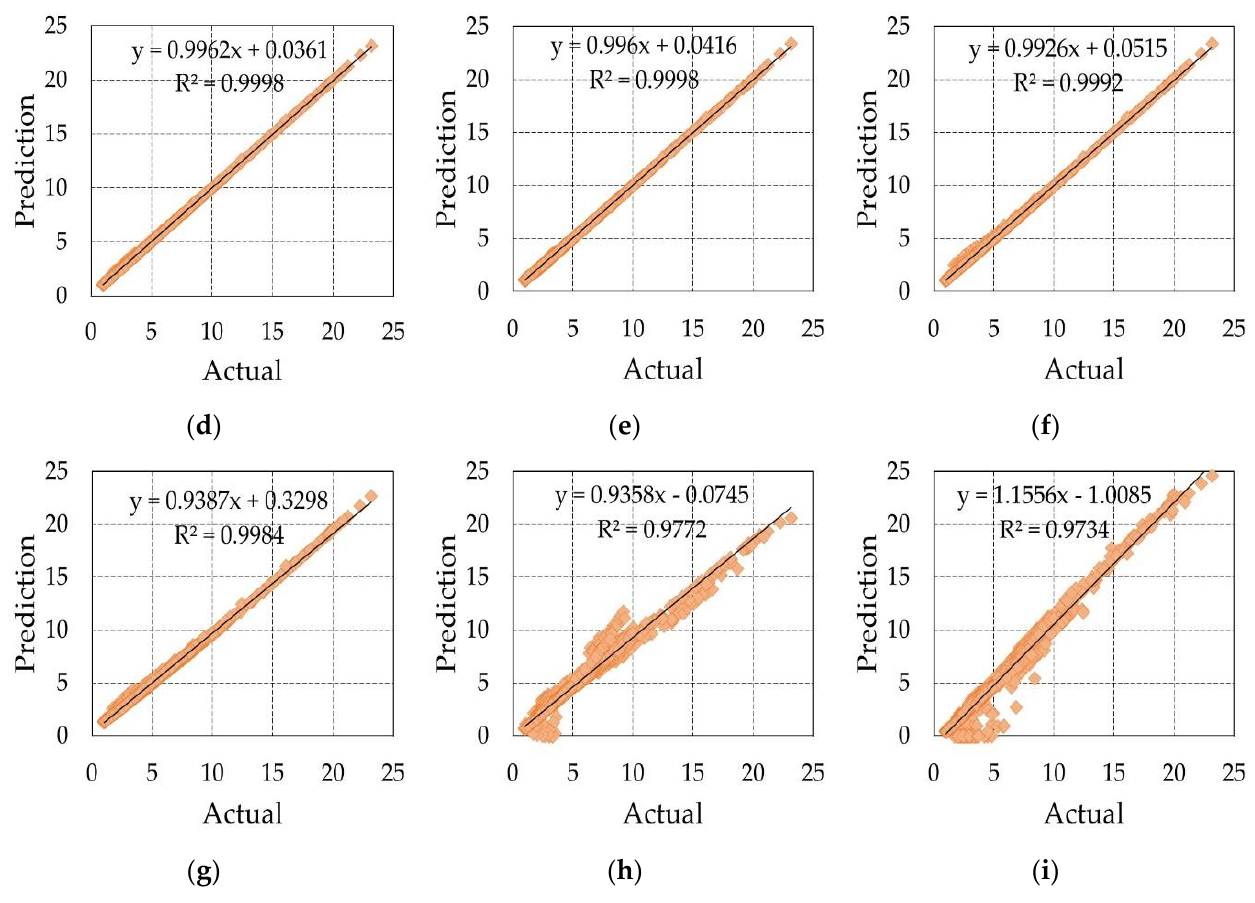
Figure 6. R 2 of prediction results of PM 2.5 concentration. ( a ) LM-Hidden layer-1; ( b ) LM-Hidden layer-3; ( c ) LM-Hidden layer-5; ( d ) BR-Hidden layer-1; ( e ) BR-Hidden layer-3; ( f ) BR-Hidden layer-5; ( g ) BFG-Hidden layer-1; ( h ) BFG-Hidden layer-3; ( i ) BFG-Hidden layer-5.